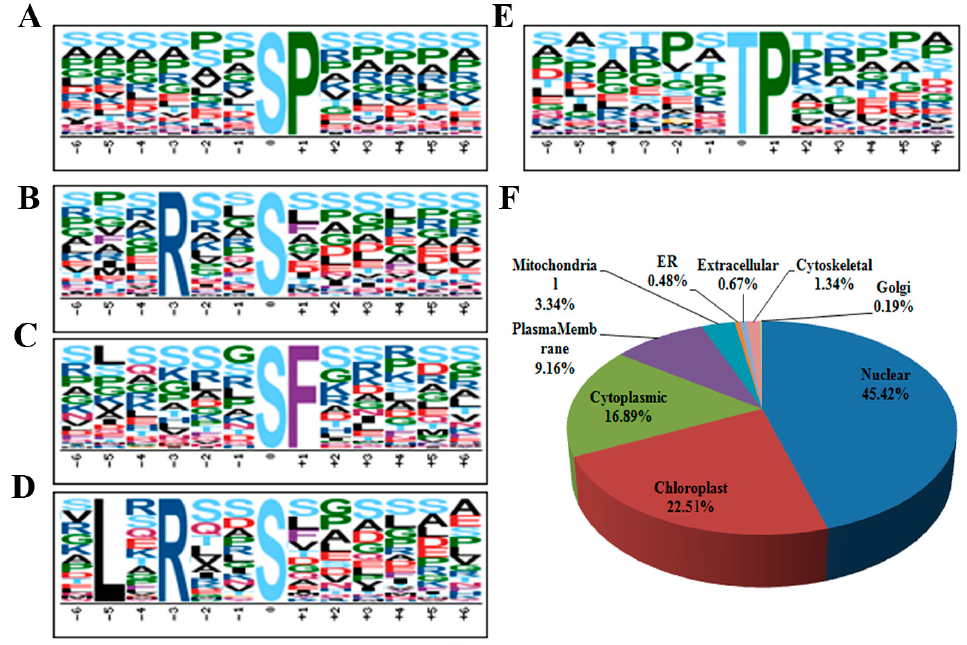
Figure 3. Motif-X analysis of the over-represented motifs around the phosphosites of the differentially phosphorylated (DP) proteins in response to ABA treatment. ( A ) (sP); ( B ) (Rxxs); ( C ) (sF); ( D ) (LxRxxs); ( E ) (tP); ( F ) Distribution of the DP phosphoproteins in subcellular compartments. By using the protein subcellular localization prediction tool WoLF PSORT (http://www.